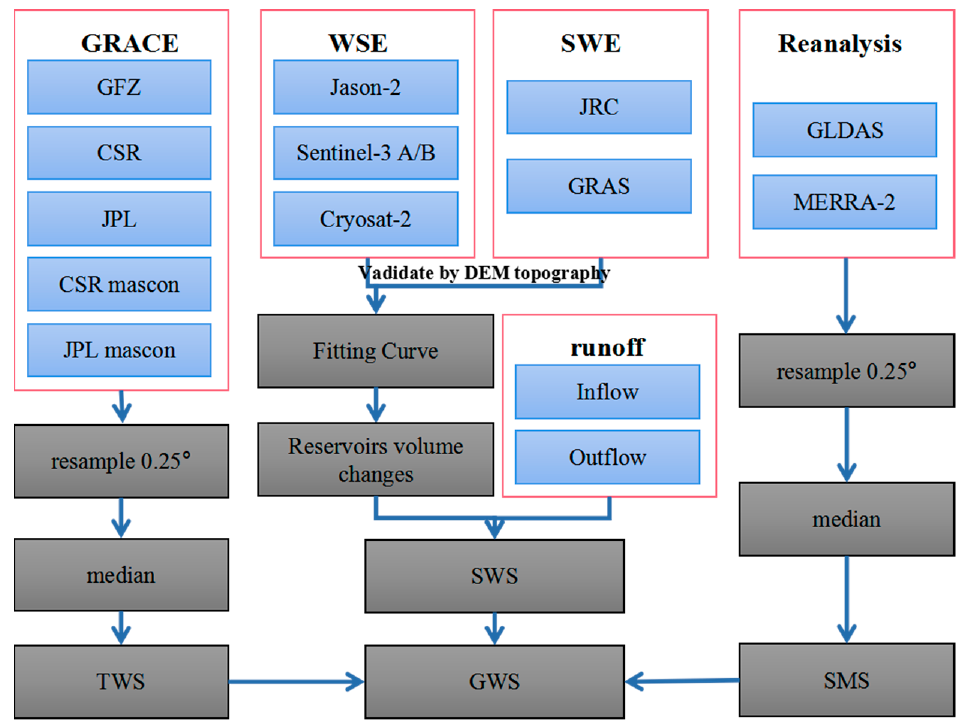
Figure 2. Research flow chart. Abbreviations, TWS: total water storage; SWE: surface water extend; WSE: water surface elevation; SMS: soil moisture storage; SWS: surface water storage; GWS: groundwater storage. Table 1. Data used in this study. Abbreviations, TWSA: total water storage anomaly; SWE: surface water extend; WSE: water surface elevation; SMS: soil moisture